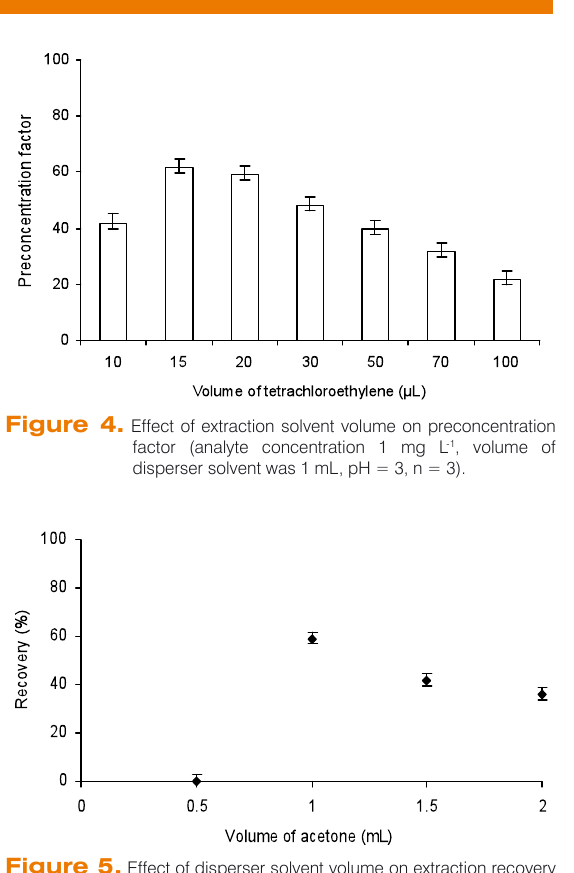
Figure 5. Effect of disperser solvent volume on extraction recovery (analyte concentration 1 mg L -1 , volume of extraction solvent was 15 µL, pH = 3, n =